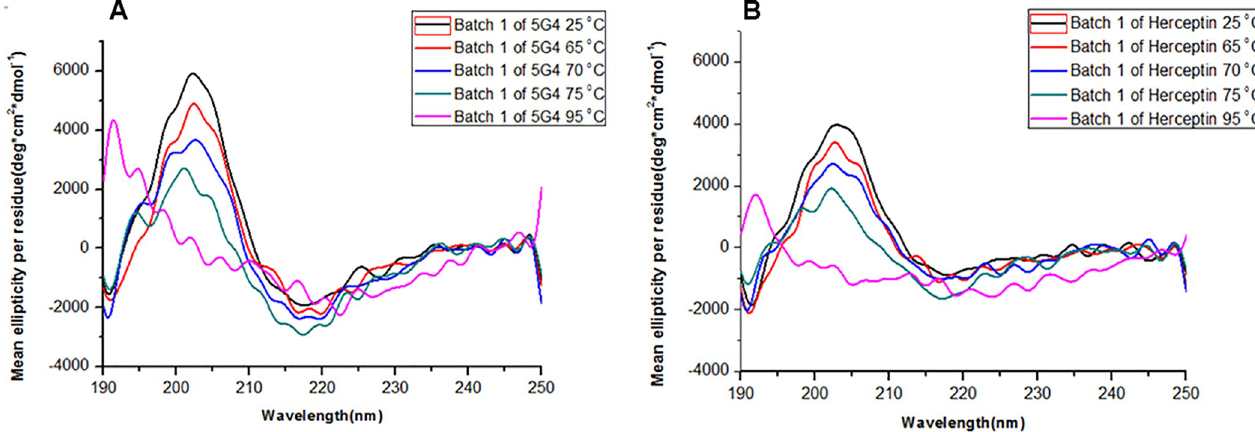
Fig 4. Thermal stability spectra by far-UV CD for 5G4 mAb and Herceptin in PBS solution. Batch 1 of 5G4 mAb (A) and batch 2 of Herceptin (B) are shown. Different temperatures of each mAb are shown: Temperature 25˚C (black), temperature 65˚C (red), temperature 70˚C (blue), temperature 75˚C (green) and temperature 95˚C